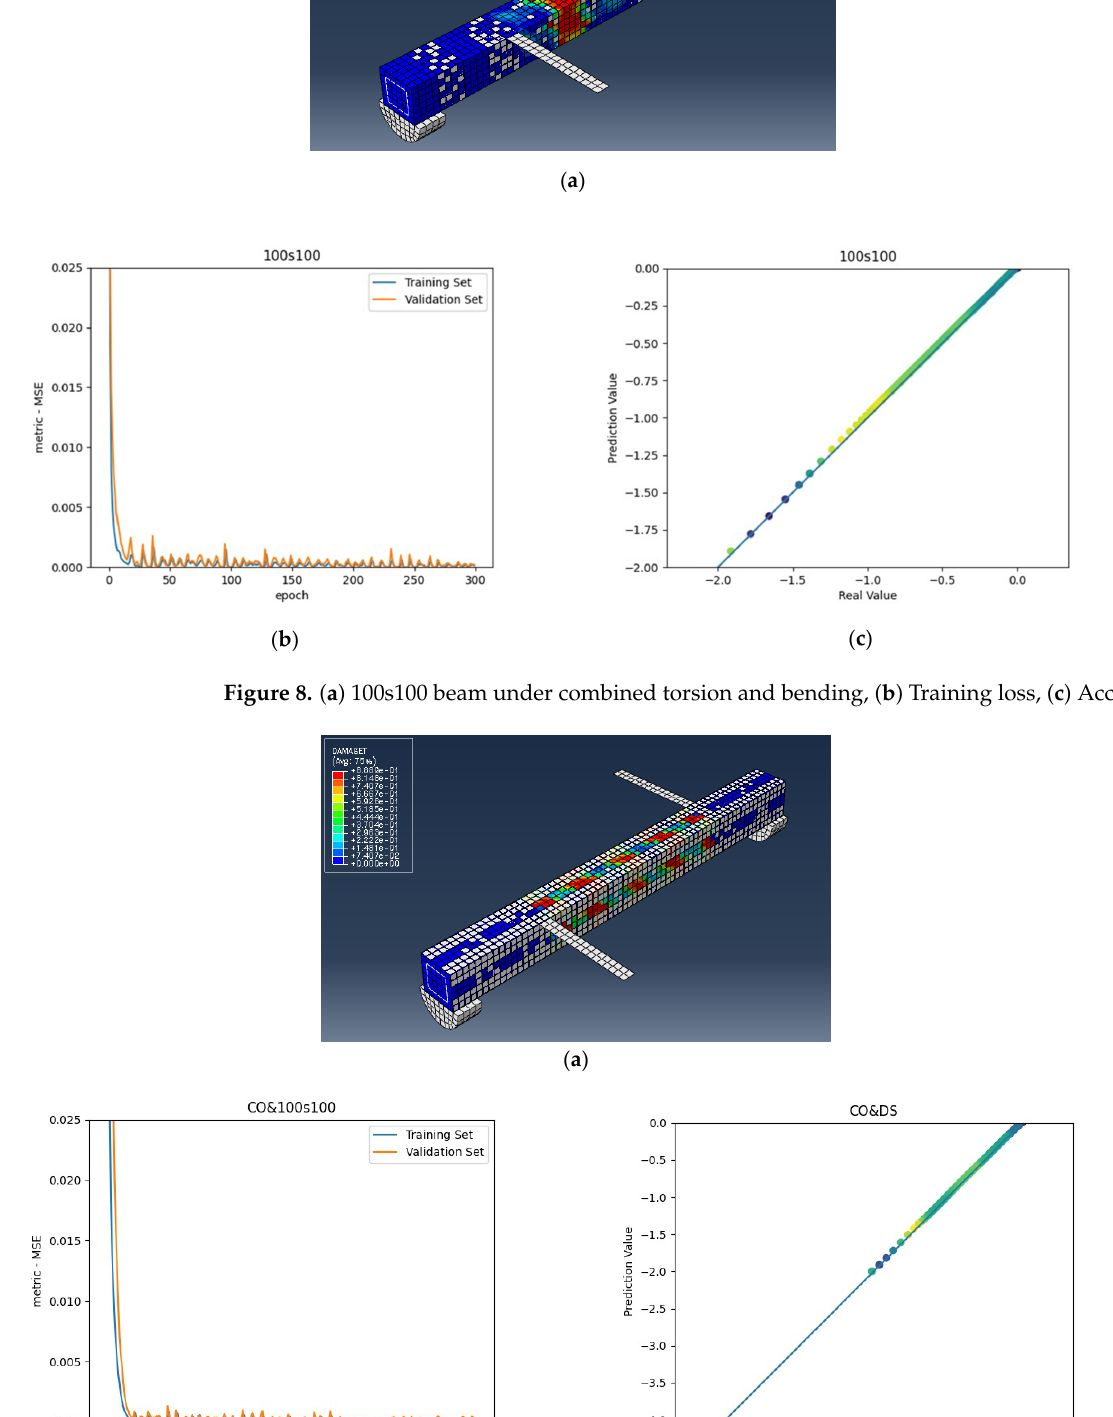
Figure 9. ( a ) CO and 100s100 beam under combined torsion and bending, ( b ) Training loss, ( c ) Accuracy.